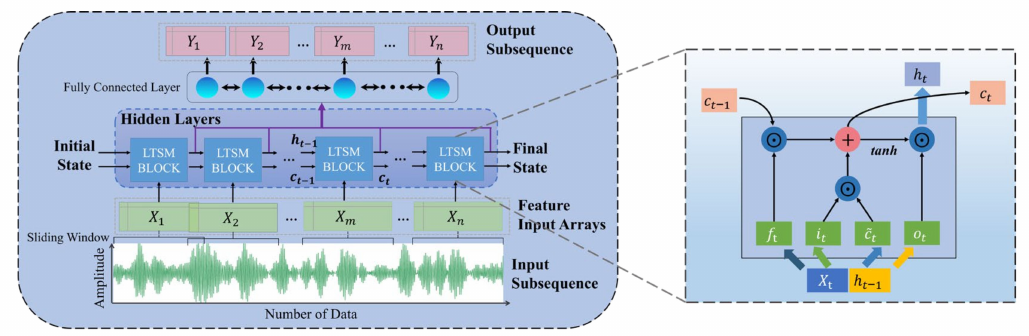
Figure 11. Prediction process for the PL subsequence combining LSTM